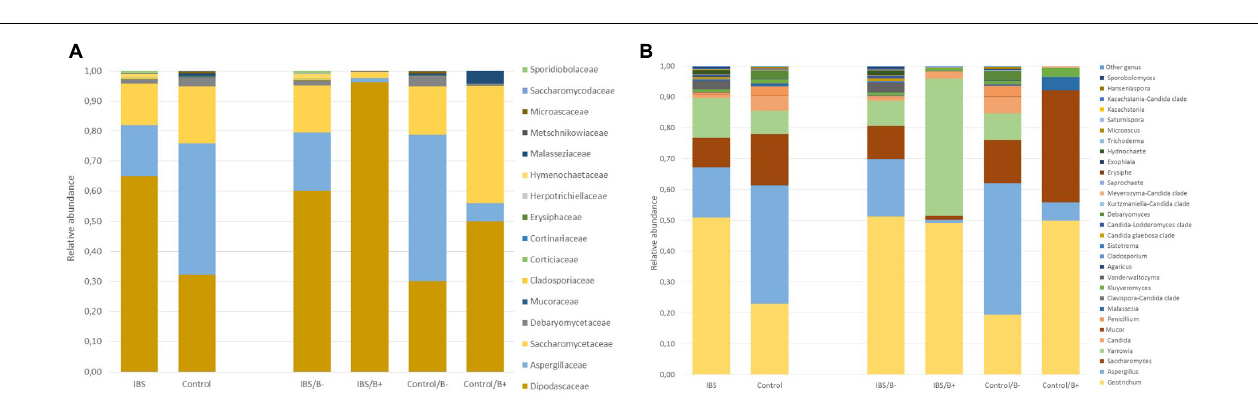
FIGURE 7 | Comparison of the fecal mycobiota composition between controls and IBS subjects at family (A) and genus (B) levels. IBS/B-: Blastocystis -negative IBS patients; IBS/B+: Blastocystis -positive IBS patients; Control/B-: Blastocystis -negative control subjects; Control/B+: Blastocystis -positive control